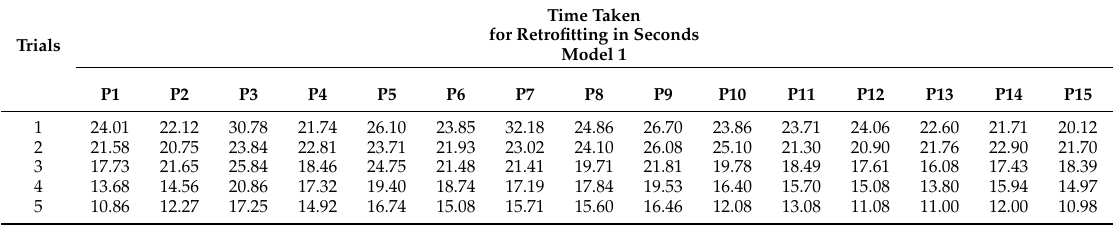
Table 3. Task 1: Participants’ time taken for retrofitting Model